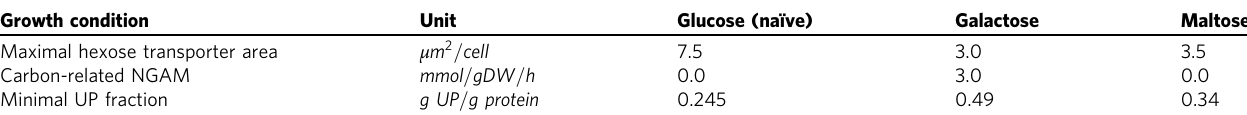
Table 2 Changes to the parameters for simulating sugar excess conditions. NGAM is non-growth related ATP maintenance. Growth